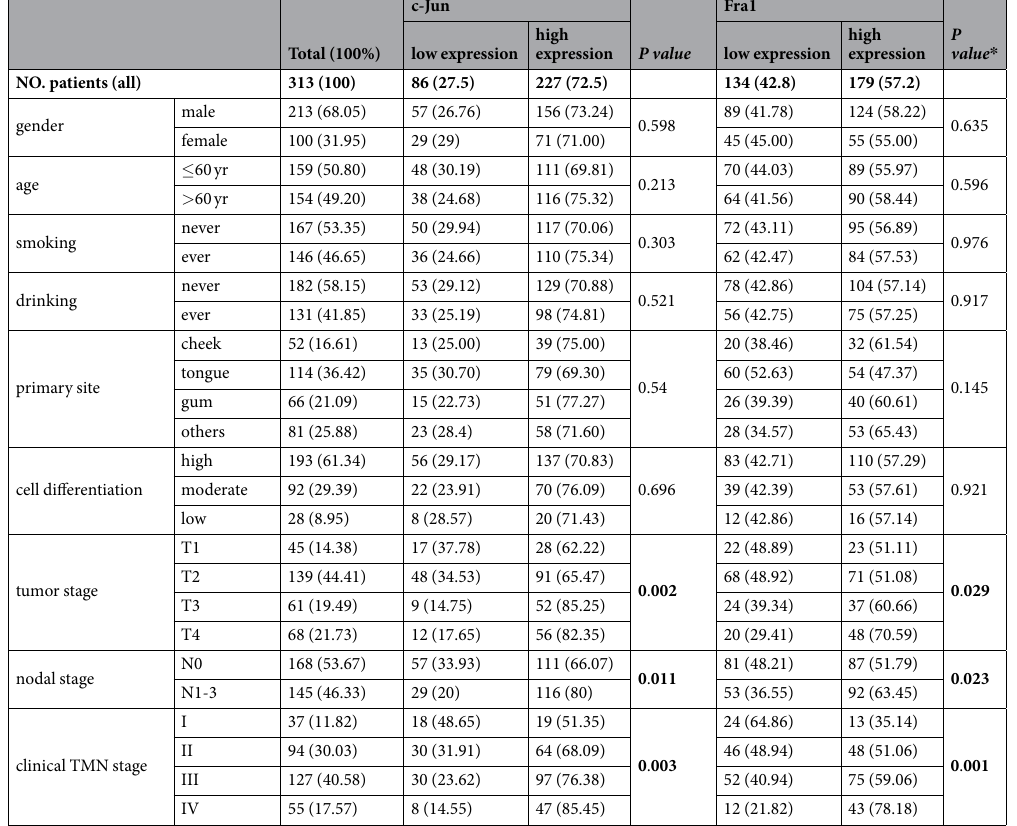
Table 1. The association between the expression of c-Jun and Fra-1 with the baseline characteristics of the patients with OSCC. * The p value was generated using χ 2 test, Fisher’s exact test and Kruskal-Wallis H